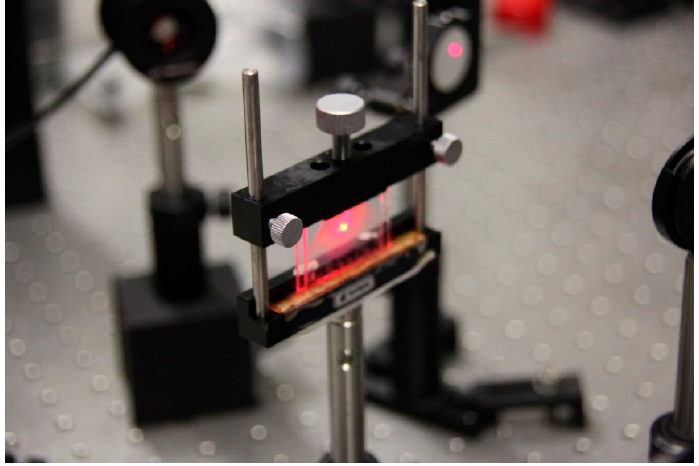
Figure 2. Reconstruction laser beam passing through the sample.